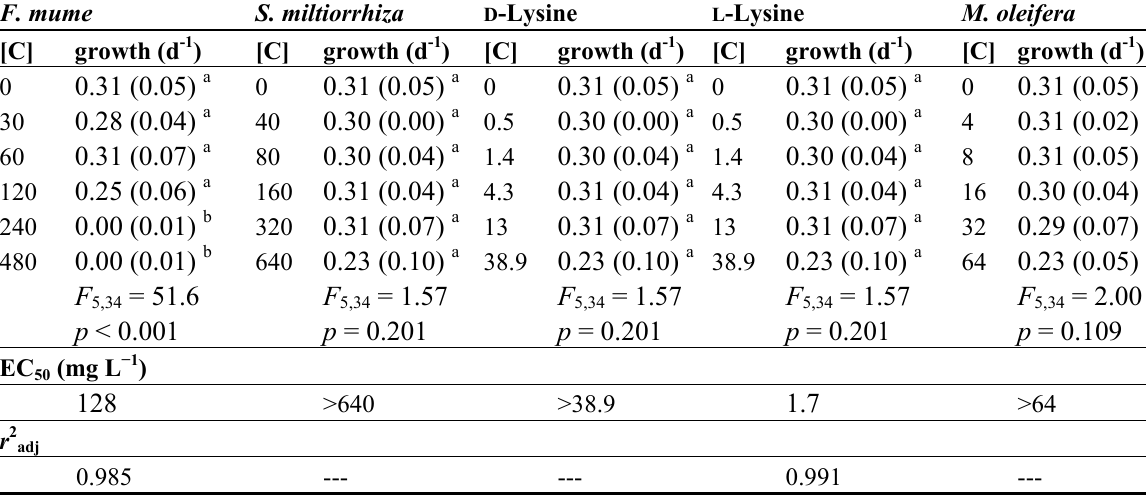
Table 4. Biovolume-based growth rates (d − 1 ) of Microcystis aeruginosa NIVA-CYA 43 exposed to different concentrations (C, mg L − 1 ) of extracts from Fructus mume , Salvia miltiorrhiza , Moringa oleifera and D - and L - lysine, including F- and P -values of one-way ANOVAs, or H -values of Kruskal-Wallis One Way Analysis of Variance on Ranks. Values between brackets indicate one standard deviation ( n = 5). Similar letters per column ( a,b,c ) indicate homogenous groups that are not different at the p = 0.05 level. Also given are EC values (mg L − 1 ) and adjusted r 2 of non-linear regression (four parameter logistic curve). F. mume S. miltiorrhiza L -Lysine M.